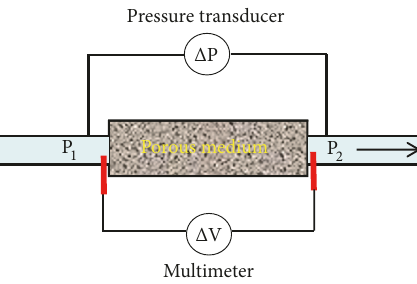
Figure 4: Schematic illustration of streaming potential measure- ment when an electrolyte is pumped through a porous medium. Δ V=V P 1 -V P 2 is the streaming potential and pressure difference.